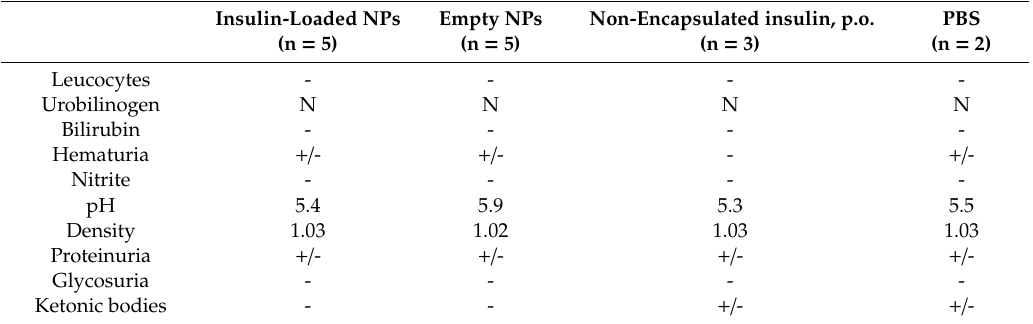
Table 4. Status of the di ff erent parameters evaluated in the urine of the rats of the di ff erent